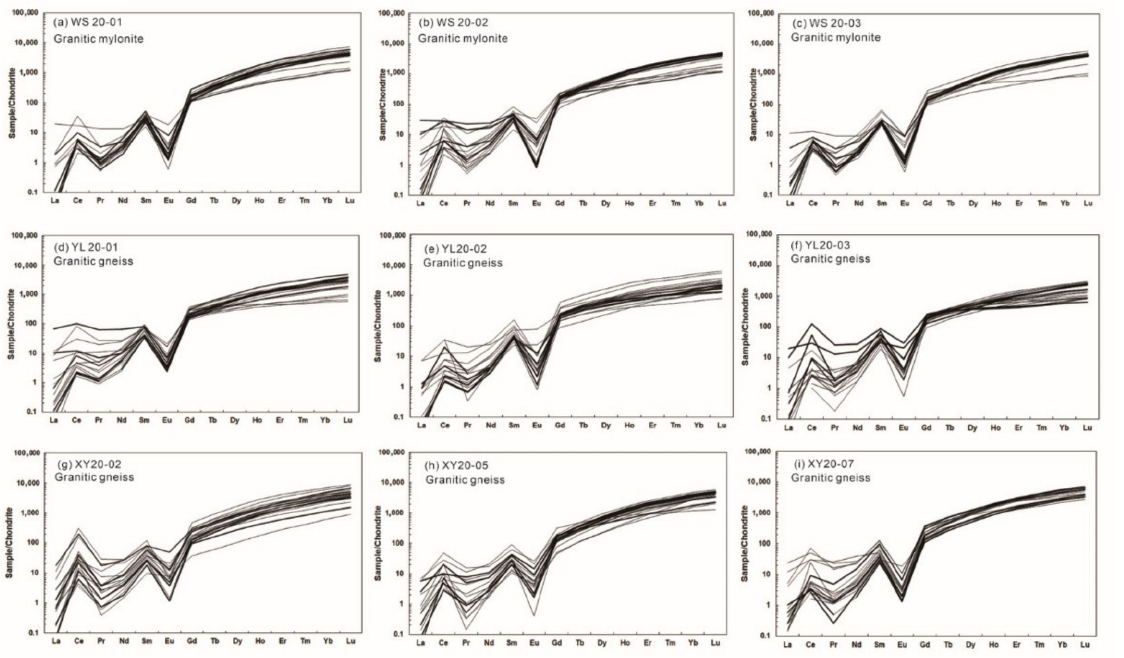
Figure 8. Chondrite-normalized REE patterns for zircons from the granitic mylonites from Wushan ( a – c ) and granitic gneisses from Yuanlong ( d – f ) and Xinyang ( g – i ) in the western margin of the